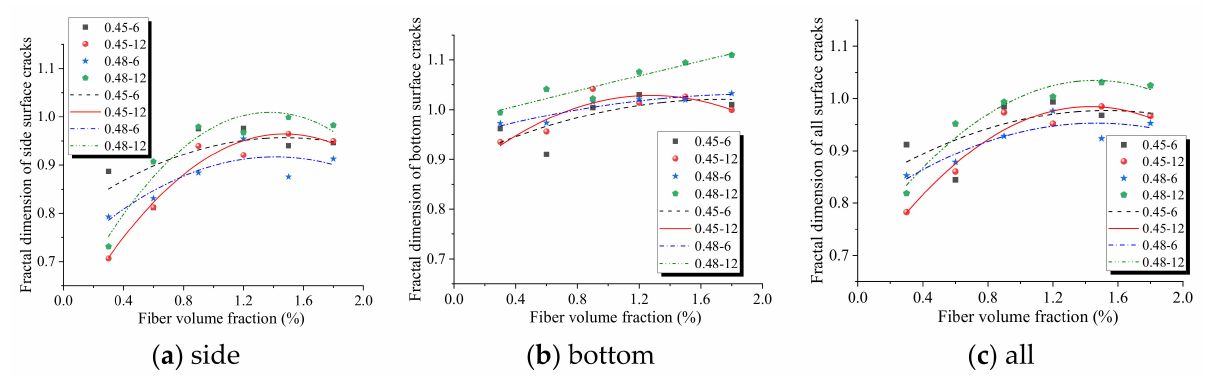
Figure 7. Relationship between fiber volume fraction and fractal